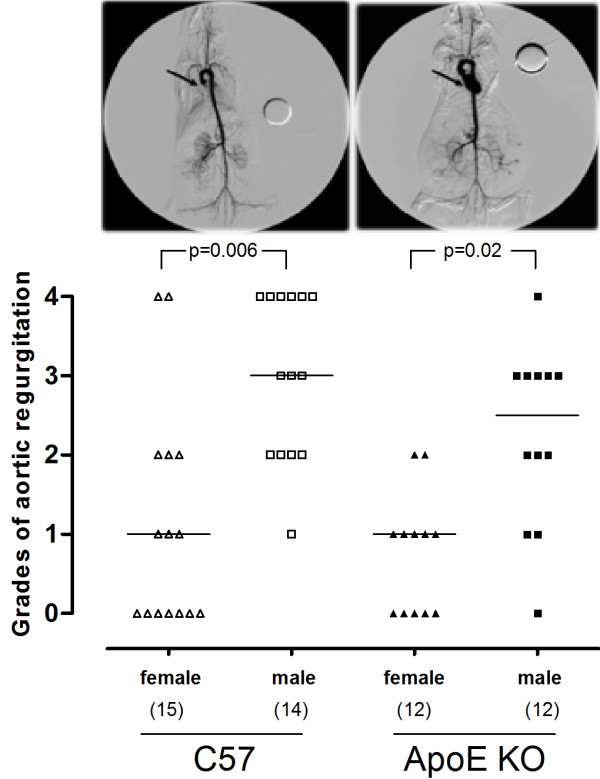
Influence of gender on aortic regurgitation in aged normocholesterolemic and hypercholesterolemic mice. Top panel: typical angiographies showing aortic regurgitation in the male (right image) but not in the female (left image). Bottom panel: scatter plot showing the severity of aortic regurgitation (grades: 0 = none, 1 = light, 2 = mild, 3 = moderate, 4 = severe) in males compared with females in both C57 and ApoE KO groups. Horizontal bars represent the median for each group. p values were calculated using the Fisher's exact test and indicate statistical significance between proportions. The number of animals per group is shown in parentheses.